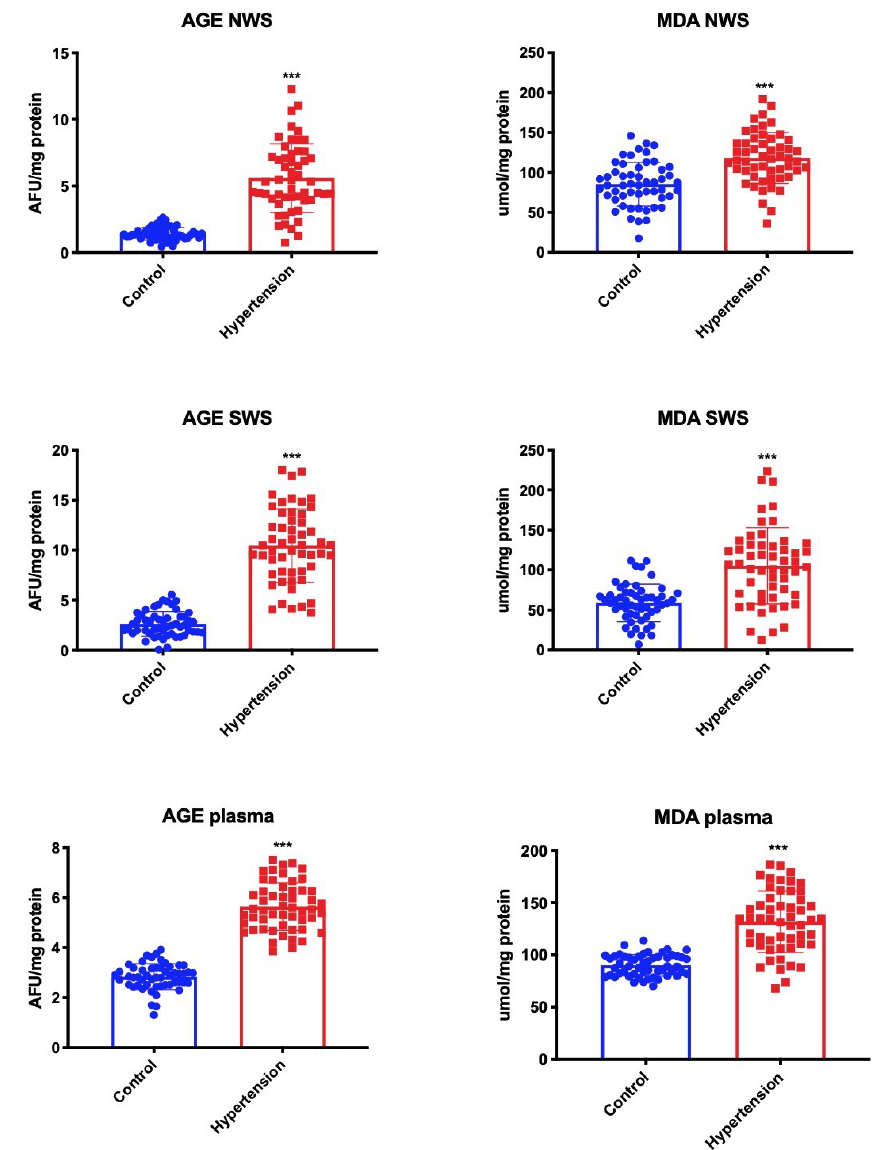
Figure 4. Oxidative stress products in children with hypertension and healthy controls. AGE—advanced glycation end products; MDA—malondialdehyde; NWS—non-stimulated whole saliva; SWS—stimulated whole saliva. Differences statistically significant at: *** p < 0.001 (Student’s t-test).